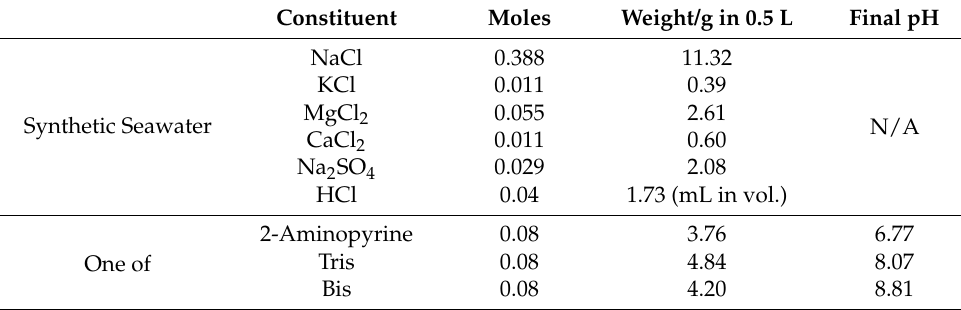
Table 1. Chemical composition of synthetic seawater. Constituent Moles Weight/g in 0.5 L Final pH NaCl 0.388 Synthetic Seawater